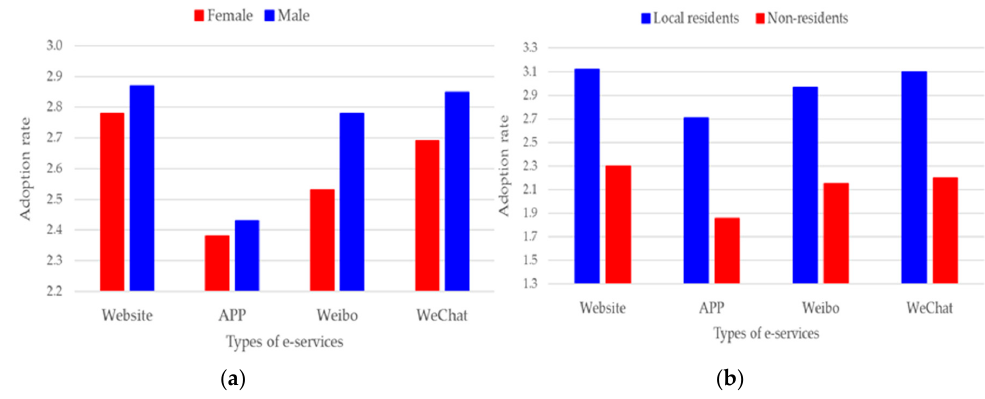
Figure 4. Gender and Local residency differences on adoption of local e-government services: ( a ) Female and male in adoption of four services; ( b ) Local residents and non-residents in adoption of four services.